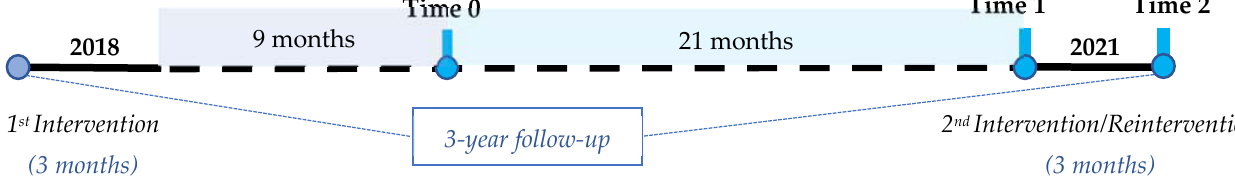
Figure 1. Measurements at trial profile (Time 0, Time 1, and Time 2). Figure 1 shows the time periods when assessments and reintervention were carried out, along the 3 ‐ year follow ‐ up.